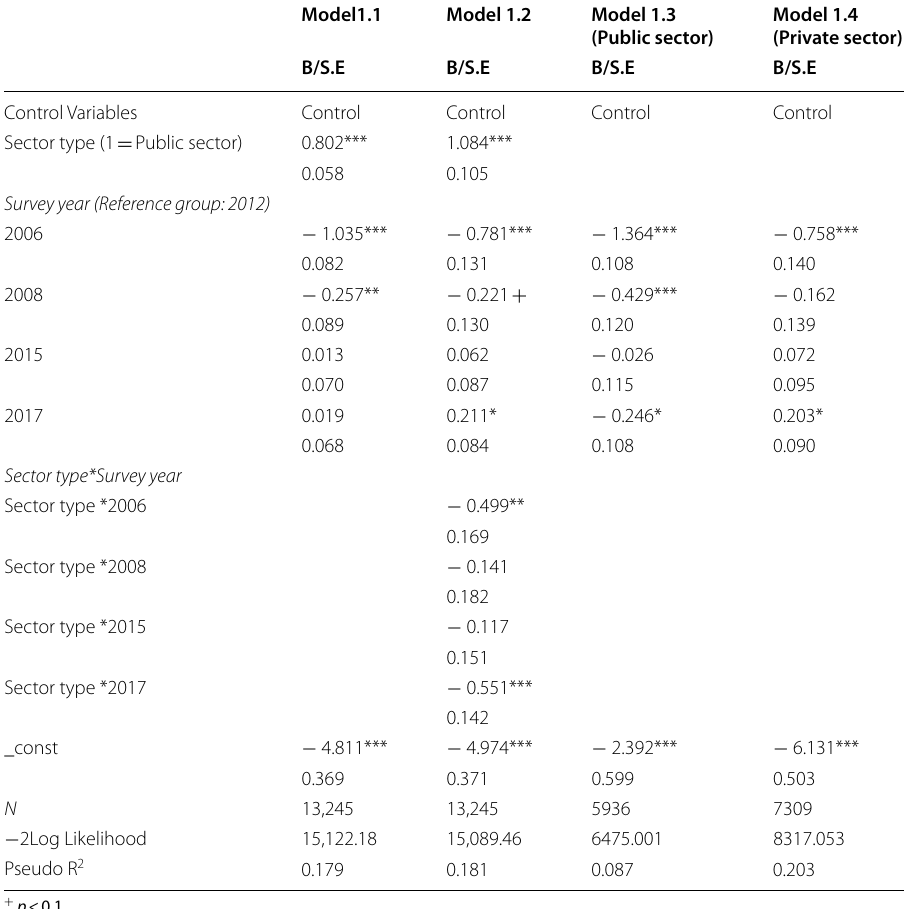
Table 2 Logistic analysis of obtaining stable